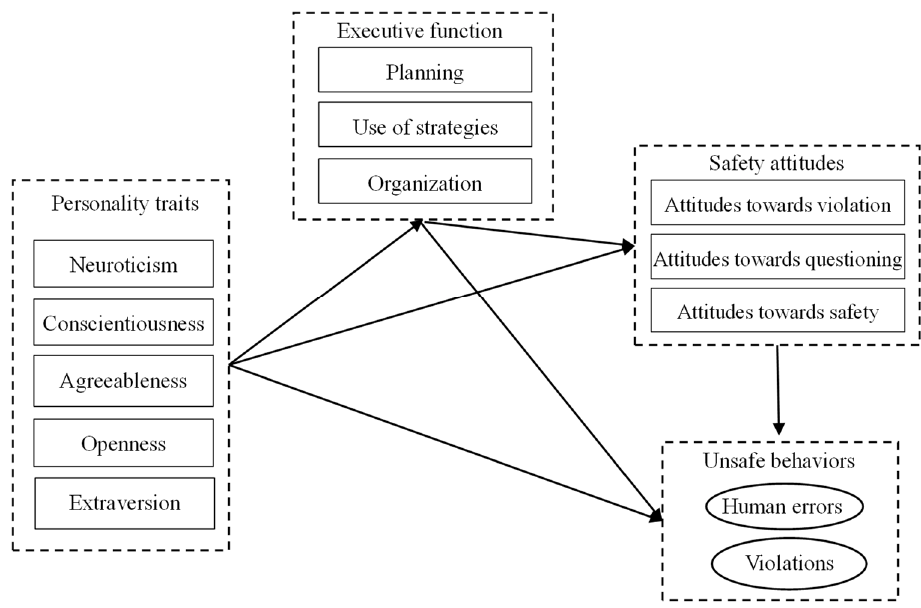
Figure 1. The contextual mediated model proposed in this study.